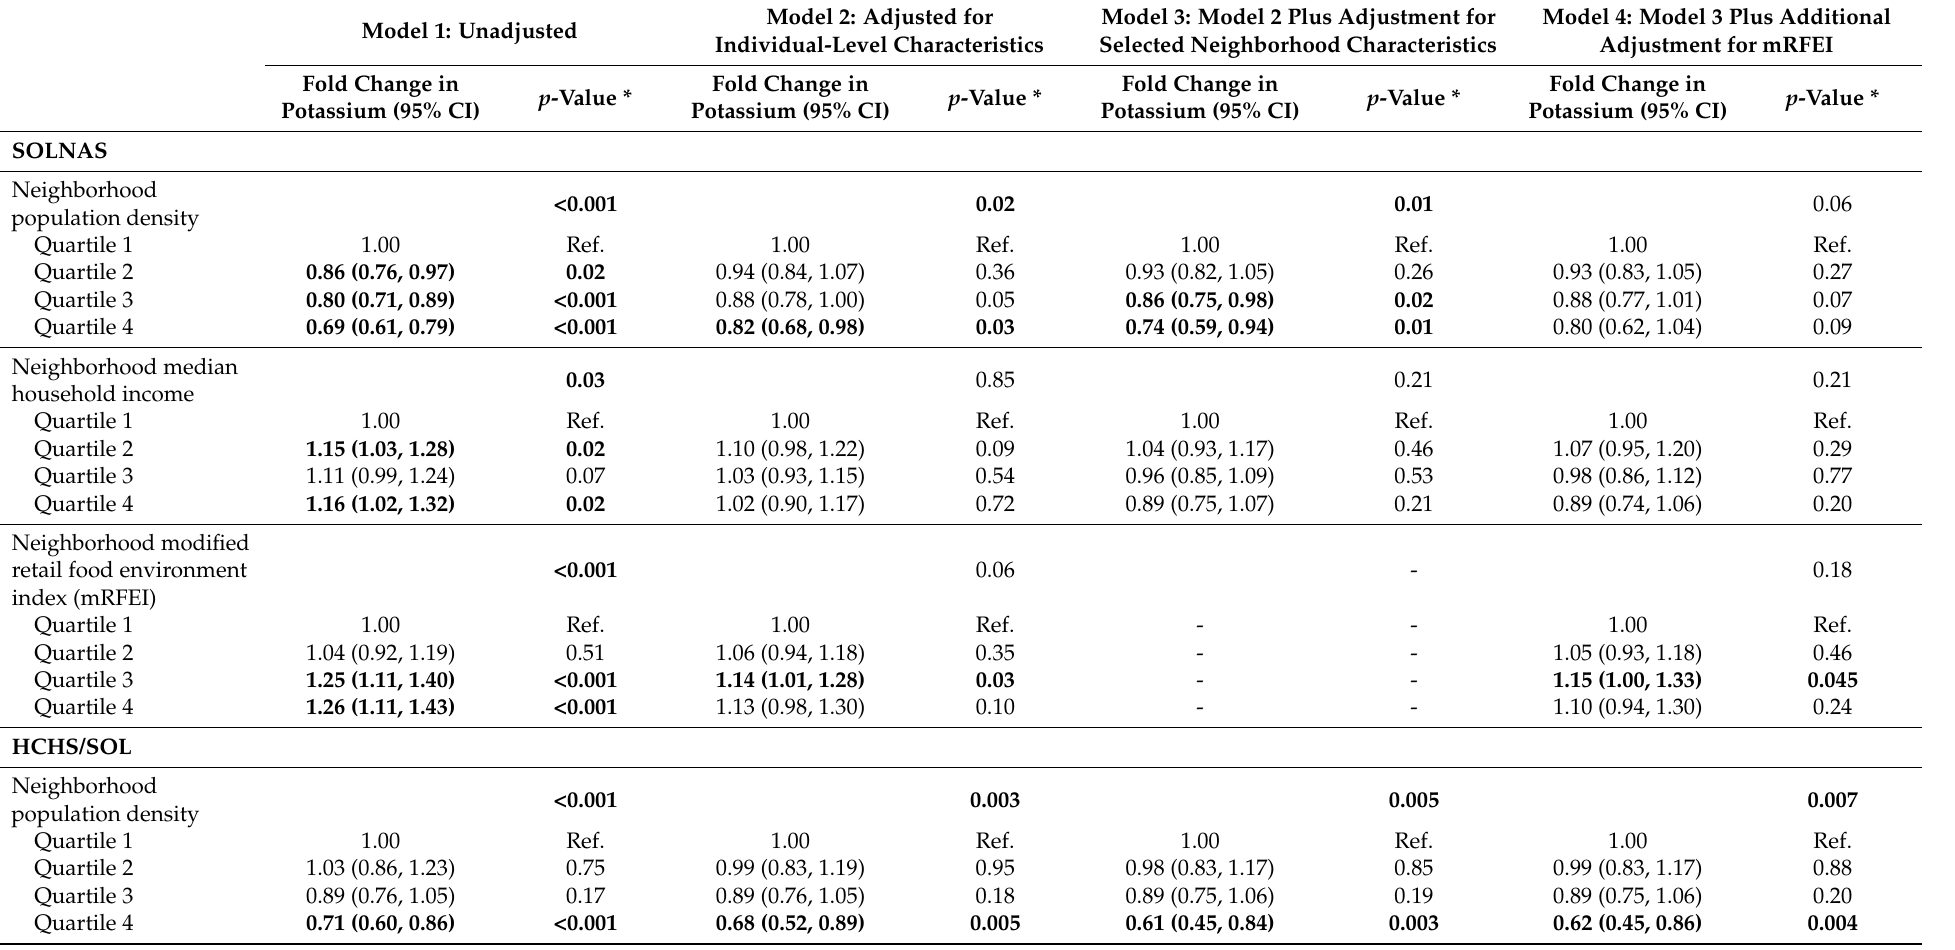
Table 2. Change in the geometric mean of 24-h potassium intake by neighborhood characteristics, SOLNAS ( N = 440) and HCHS/SOL ( N = 13,835) participants. Model 2: Adjusted for Model 3: Model 2 Plus Adjustment Model 1: Unadjusted